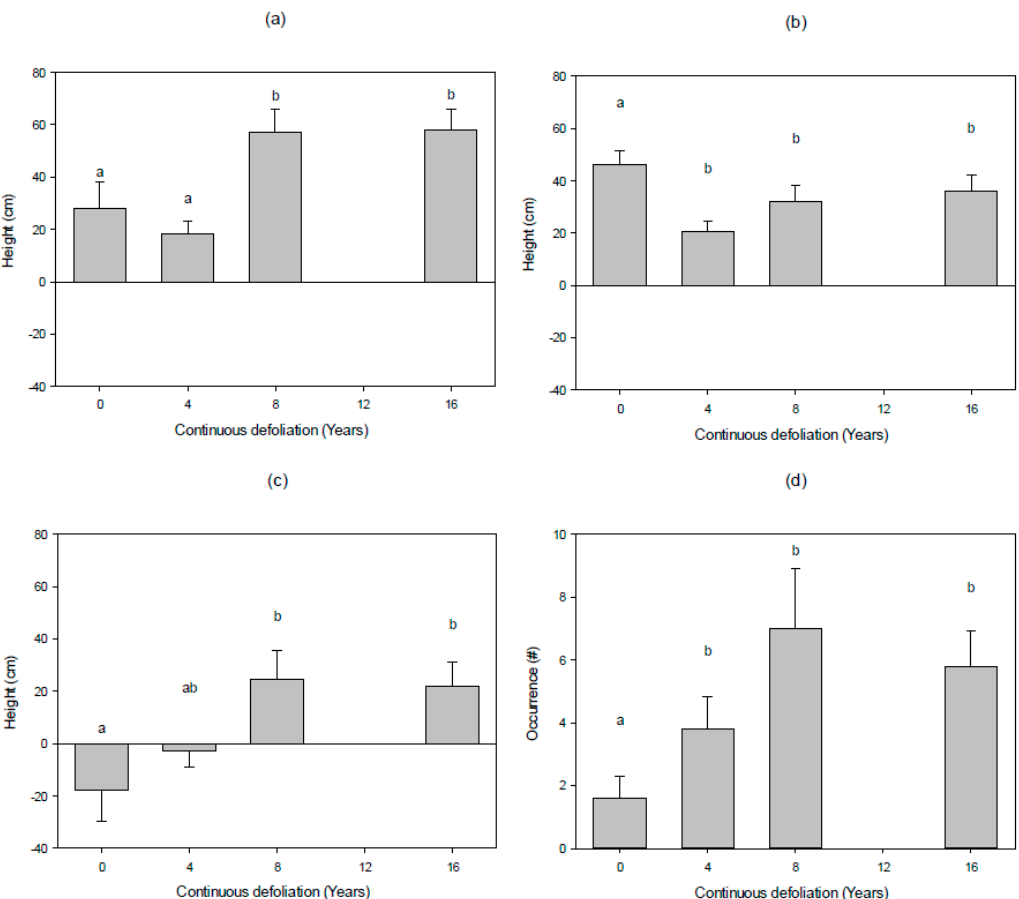
Figure 3. Mean surface biomass height by years of continuous spruce budworm defoliation from 1993–2008 in boreal mixedwood forest near Warren, Ontario: ( a ) Downed woody debris height (DWDH; n = 25); ( b ) Herbaceous height ( n = 25); ( c ) Difference between DWDH and herbaceous height ( n = 25); and ( d ) Downed woody debris (DWD) occurrence ≥ 7.0 cm ( n = 5). Means with the same letters among treatments were not significantly different (Wilcoxon rank sum test; p < 0.05). Error bars show standard error of the mean.